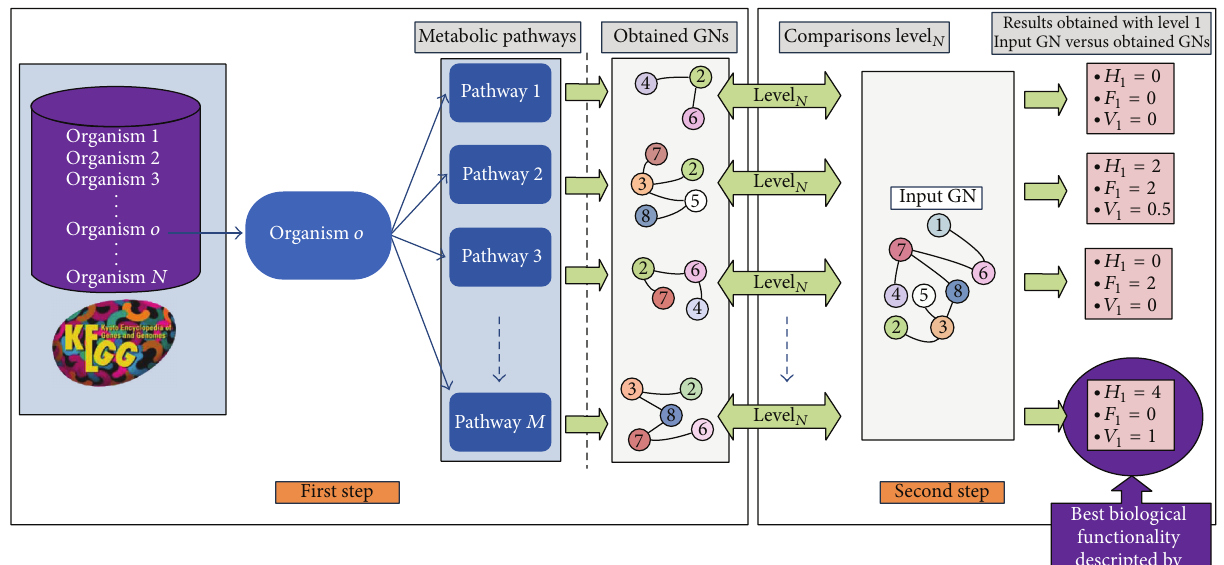
Figure 1: A schematic representation of GeneNetVal methodology. In the first step, organism o’s information is extracted from KEGG database. Each of the M metabolic pathways is processed to obtain M gene networks. In the second step, M evaluations of the input network are carried out. Note that the results presented were obtained by applying our approach at level 1.